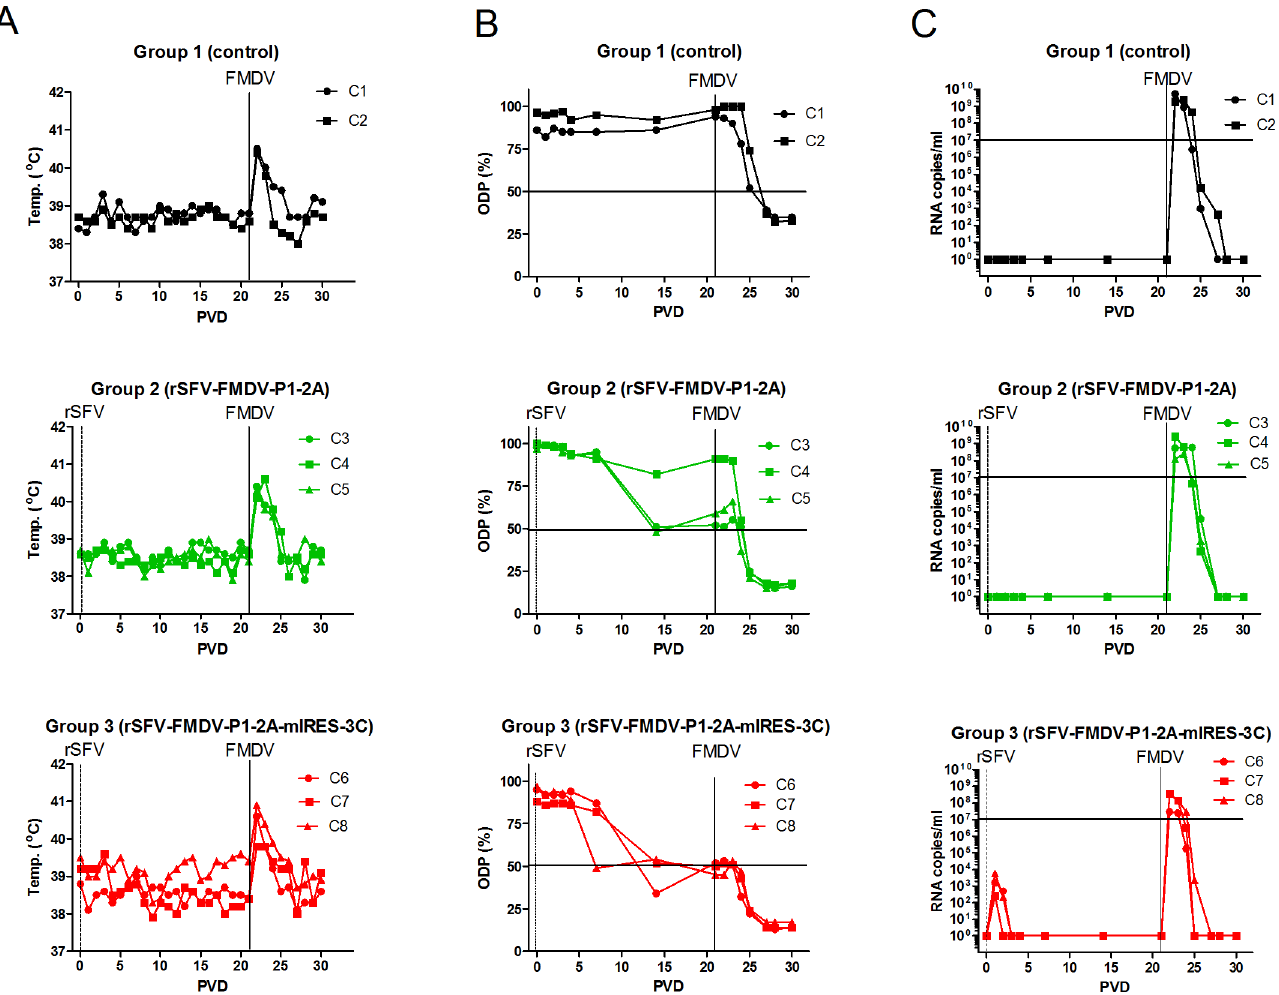
Fig 5. Vaccination of cattle with rSFV-FMDV particles and response to FMDV challenge. The indicated animals (in experiment 1) were unvaccinated (controls, C1, C2) or vaccinated on post-vaccination day (PVD) 0 with either the rSFV-FMDV-P1-2A (calves C3-C5) or the rSFV-FMDV-P1-2A-mIRES-3C (calves C6-C8) vectors (indicated by vertical dotted line, marked rSFV) and challenged with FMDV on PVD 21 (indicated by vertical line, marked FMDV). (A) Body (rectal) temperatures in each animal were monitored on a daily basis. (B) Serum samples collected at each indicated day were assayed for anti-FMDV antibodies in a serotype O-specific blocking ELISA. The diagnostic cut-off level (50%) in the ELISA is indicated by the horizontal line. (C) The number of FMDV RNA copies present in the serum was determined by RT-qPCRs by reference to a dilution series of a known concentration of FMDV RNA. The results are presented as copies of FMDV RNA/ml of serum. A level of 10 7 copies/ml is indicated by a horizontal line.